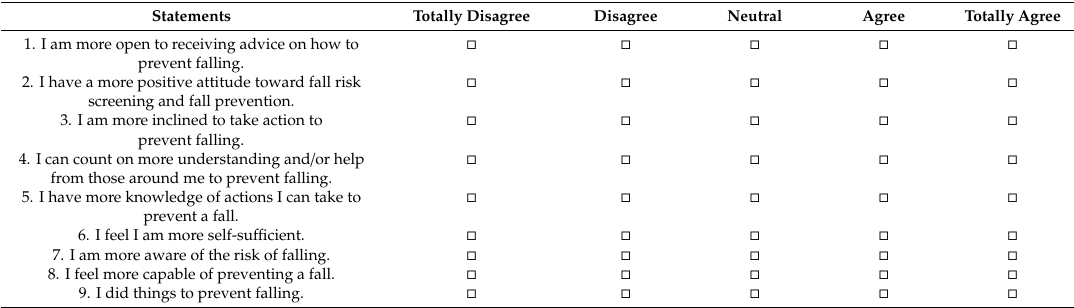
Table A1. Questionnaire for high-risk patients to assess perceptions about falls, fall risk, and fall prevention three months after screening in the